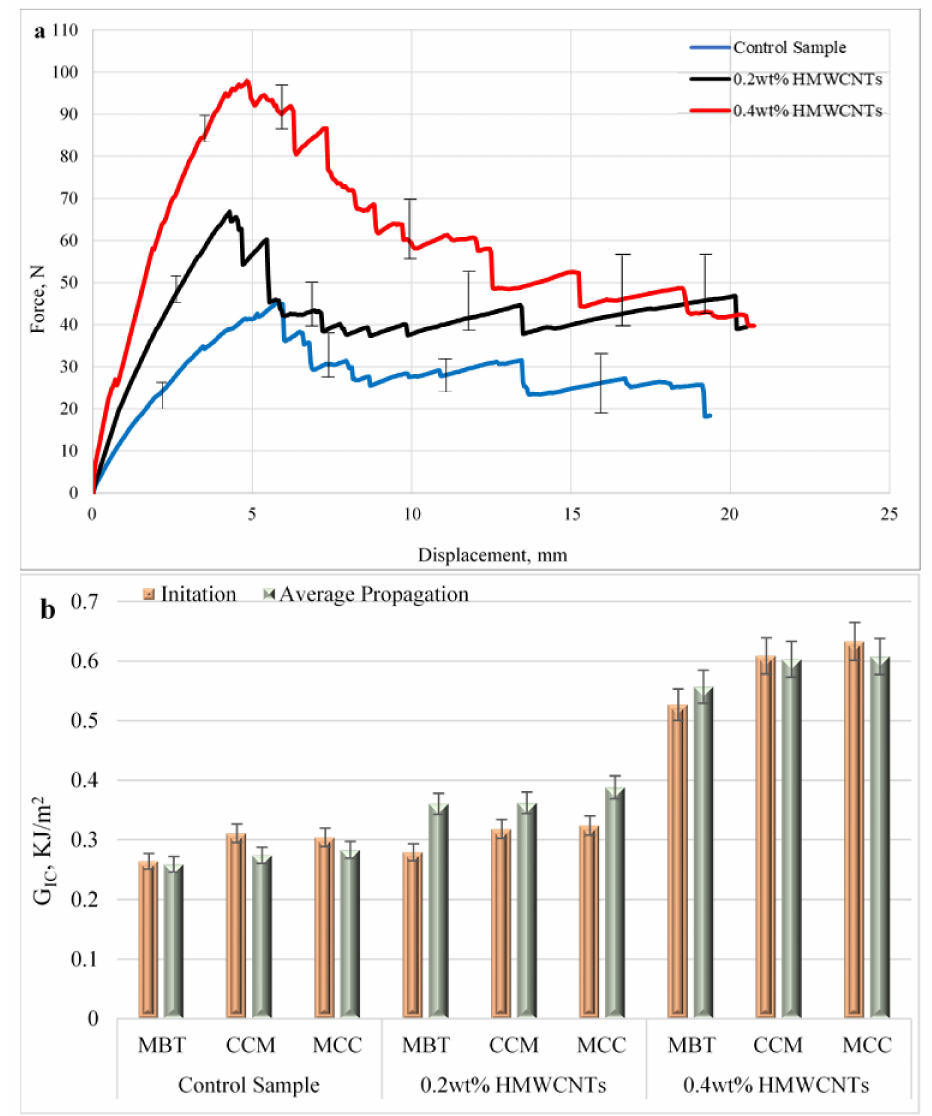
Figure 7. Mode I interlaminar fracture toughness: ( a ) average load versus displacement curves; ( b ) G IC values of the control, 0.2 wt.% and 0.4 wt.% HMWCNT composite samples. Table 3. Summary of average mode I fracture toughness of the control, 0.2 wt.%, and 0.4 wt.% HMWCNT composite